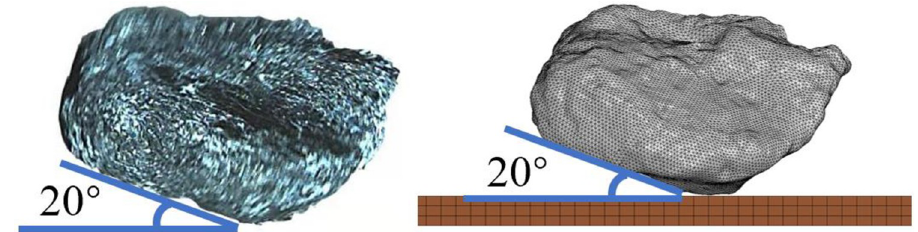
Fig 5. The finite element of coal falling test. For true coal block (left) and finite element model